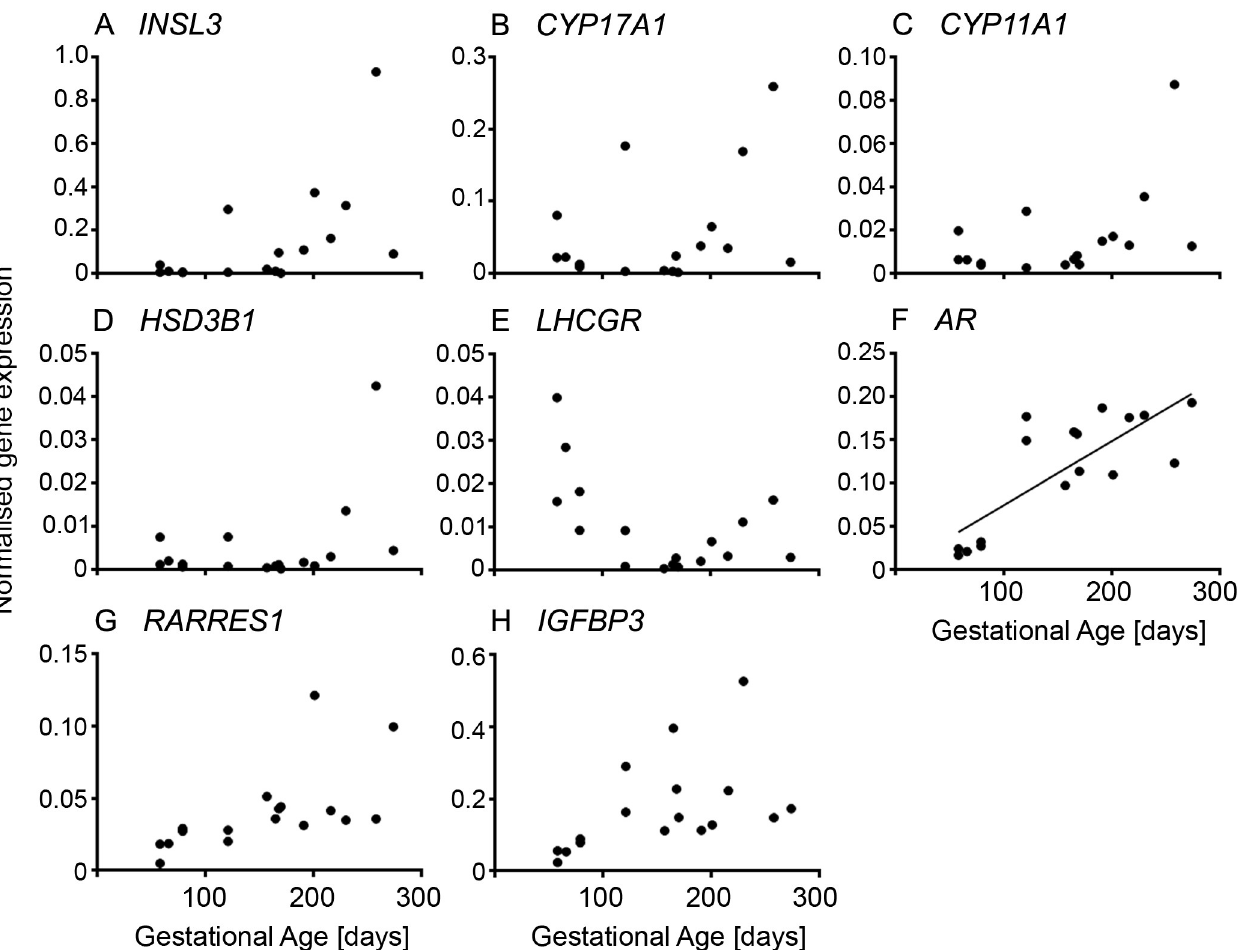
Fig 3. Steroidogenesis and growth factor signalling in fetal ovarian development. Expression levels of genes for each animal are plotted against gestational age in days (n = 16 or 17 animals).